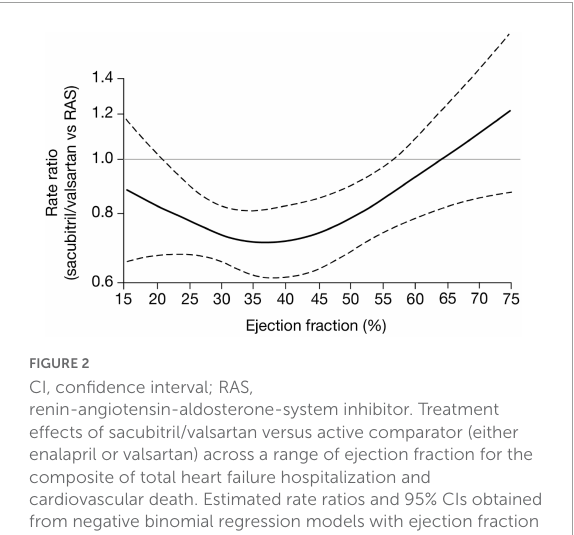
FIGURE2 CI, confidence interval; RAS, renin-angiotensin-aldosterone-system inhibitor. Treatment effects of sacubitril/valsartan versus active comparator (either enalapril or valsartan) across a range of ejection fraction for the composite of total heart failure hospitalization and cardiovascular death. Estimated rate ratios and 95% CIs obtained from negative binomial regression models with ejection fraction expressed via restricted cubic spline